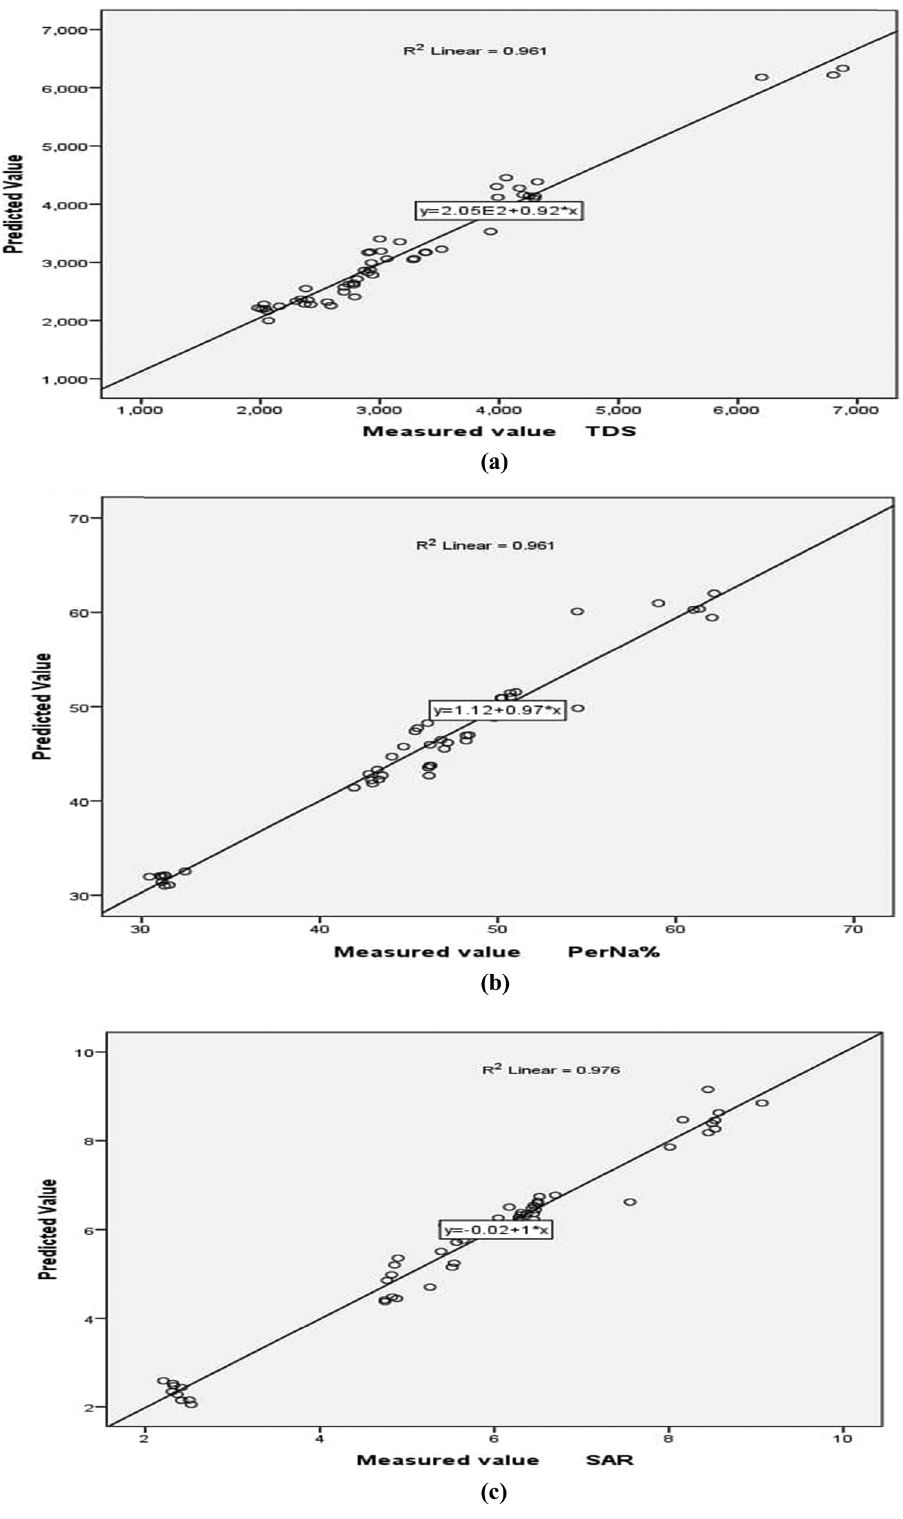
Figure 5: The comparison between measured and estimated salinity indices. ( a ) The comparison for TDS, ( b ) the comparison for Na%, and ( c ) the comparison for